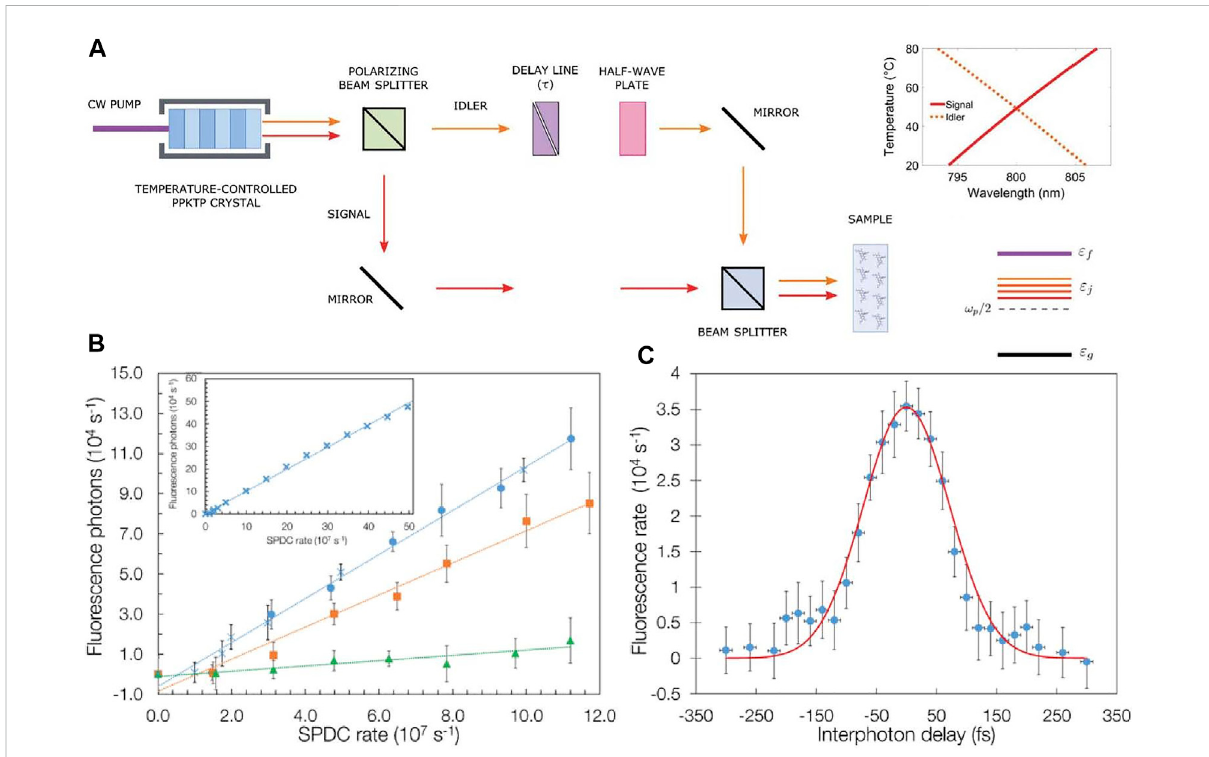
FIGURE 7 (A) Experimental illustration of temperature-controlled quantum nonlinear spectroscopy. Reprinted with permission from ref. [126]. Copyright (2022) by the American Physical Society. (B) Experimental measured fl uorescence rate of entangled two-photon absorption as a function of the SPDC photon-pair fl ux for different Rh6G concentrations in ethanol: 110 mmol/L (blue circles); 4.5 mmol/L (orange squares), and 38 μ mol/l (green triangles). (C) Temporaldependenceof fl uorescencerateofentangledtwo-photonabsorptionfor a110 mmol/LRh6Gethanolsolutionandan SPDC fl ux of 4.2 × 10 7 pairs/s, as a function of the inter-photon delay. Reprinted with permission from ref. [127]. Copyright (2022) by the American Physical